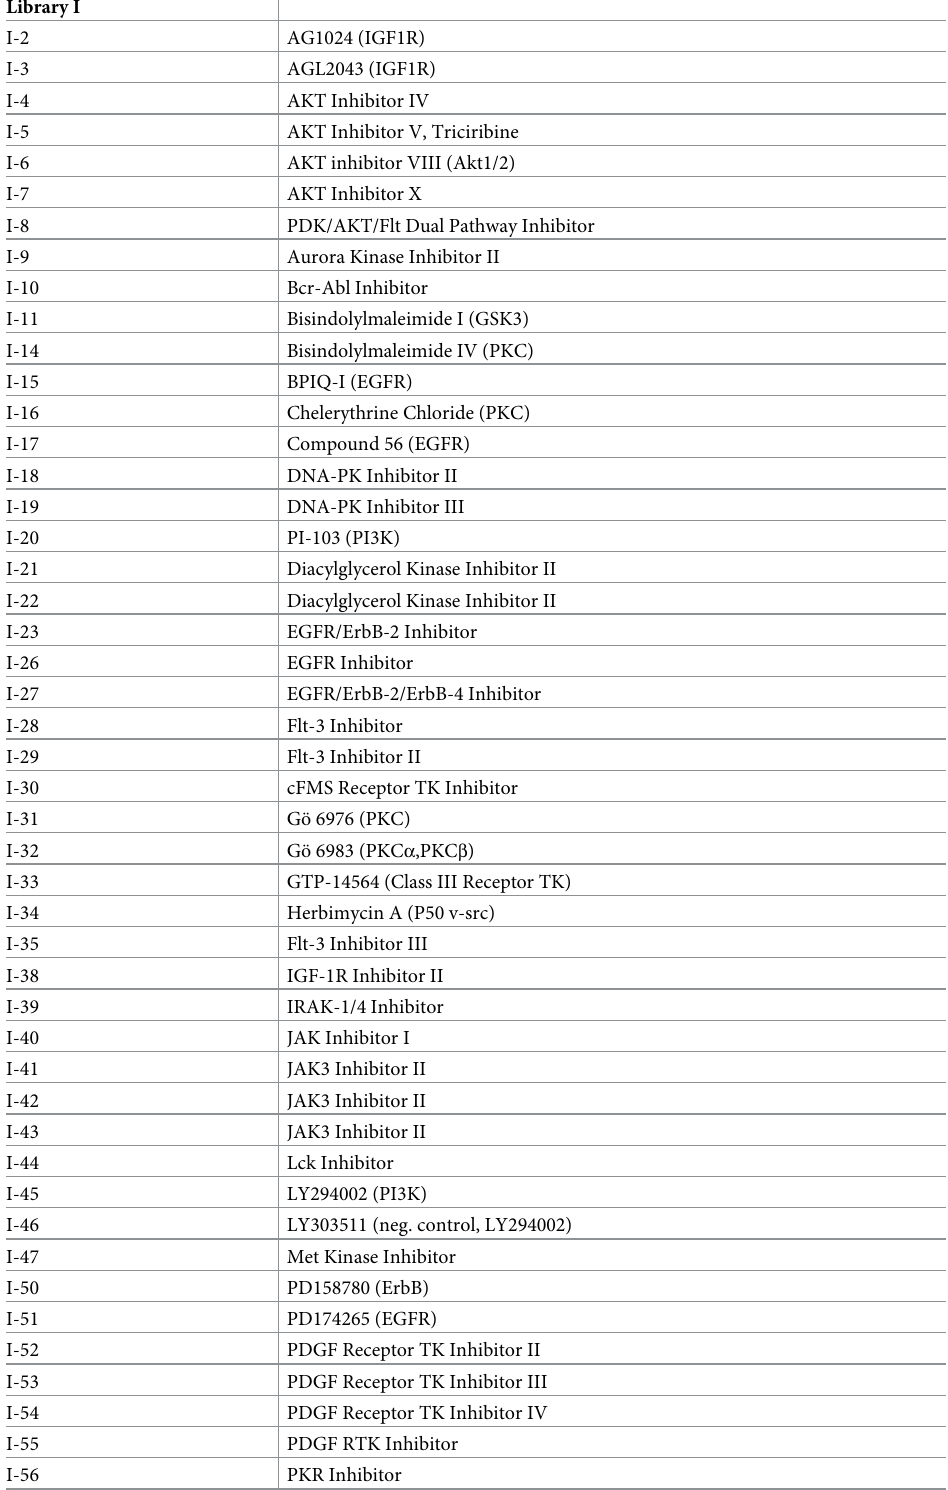
Table 2. Kinase inhibitor libraries I and